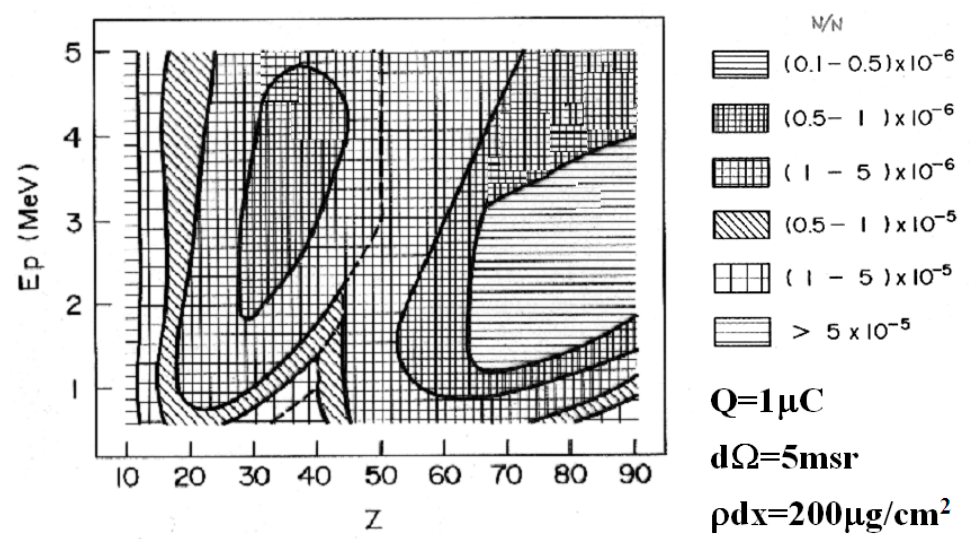
Figure 3. Detection limit of particle-induced X-ray emission (PIXE) analysis for biological samples.